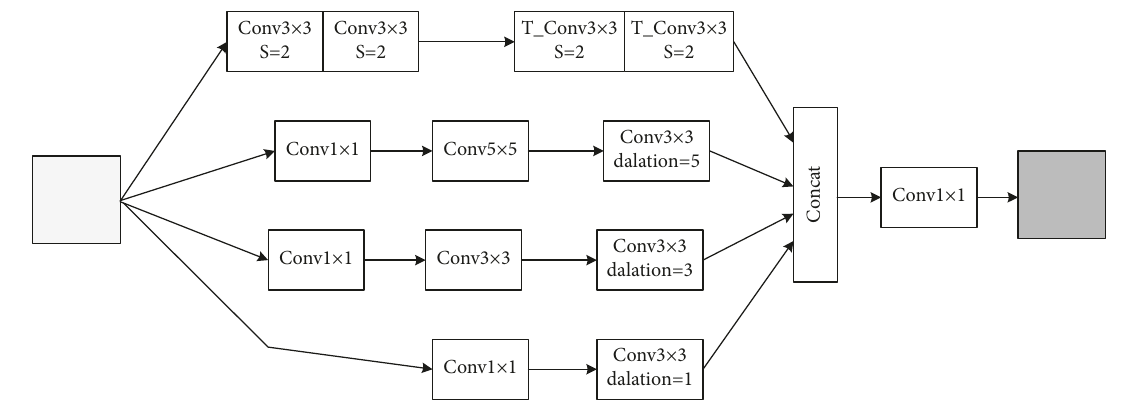
Figure 5: Semantic segmentation module SSB. Table 3: Configuration of experimental environment.